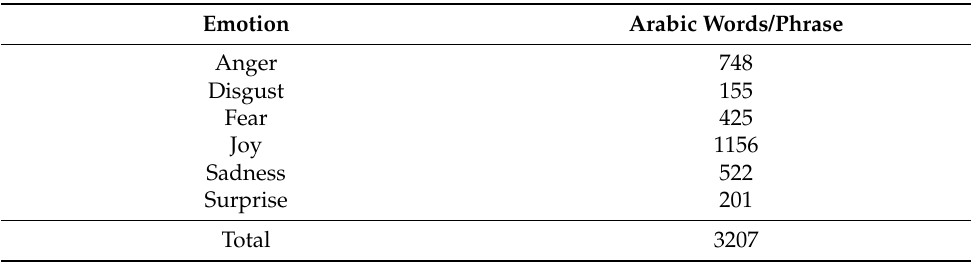
Table 3. Emotion lexicons statistics.